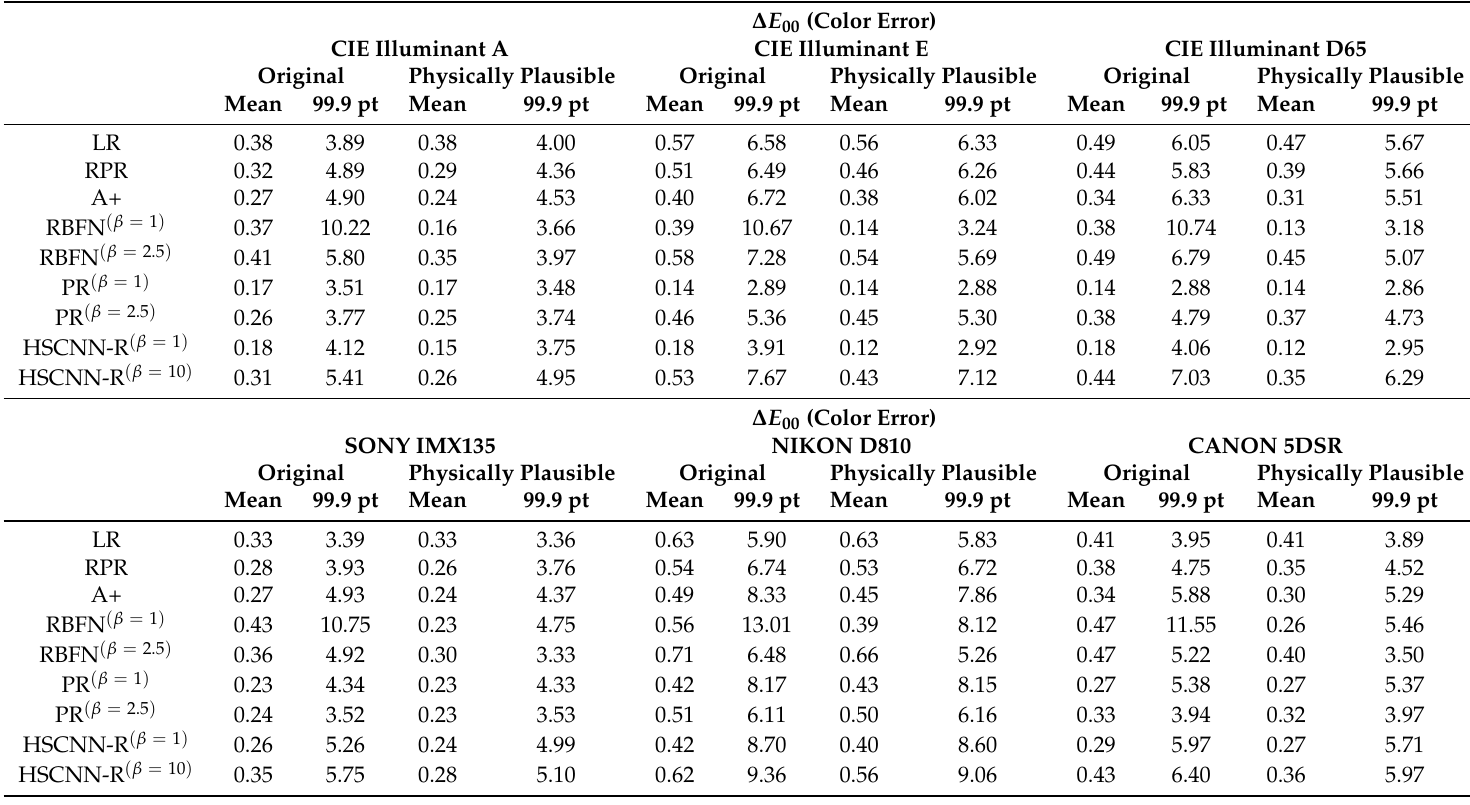
Table 5. The color accuracy when changing the illumination ( top ) or camera ( bottom ). The results are shown in the averaged per-image mean and 99.9th percentile (pt) ∆ E 00